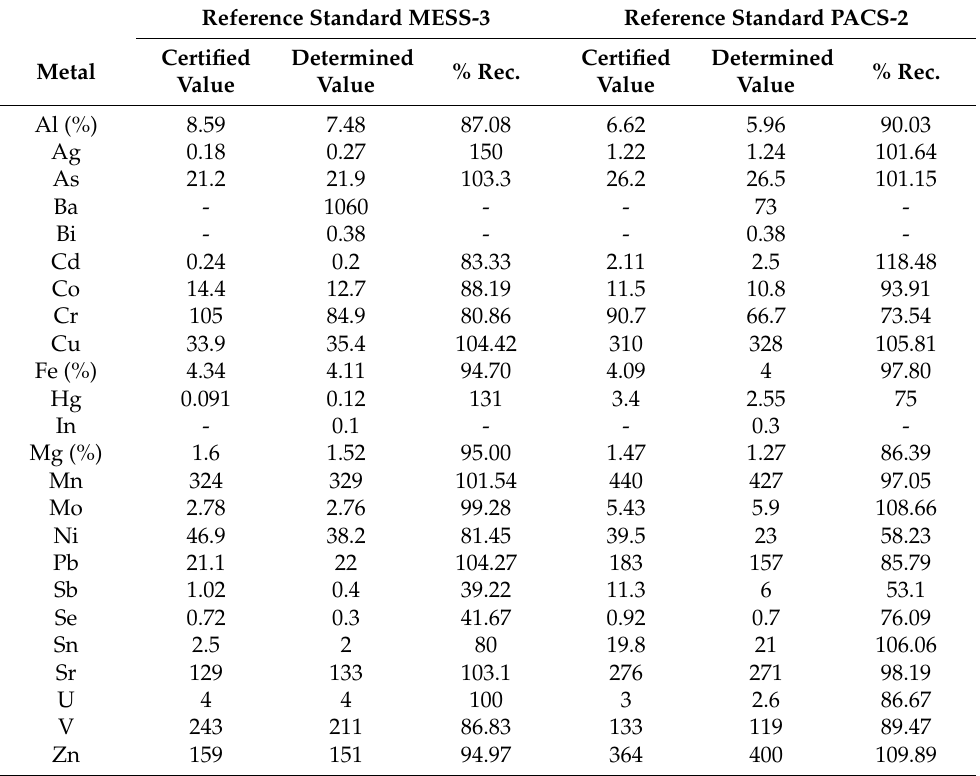
Table 2. Reference standards PACS-2, MESS-3 (sediment), for the analyzed elements with the certified value, determined value, and percentage of